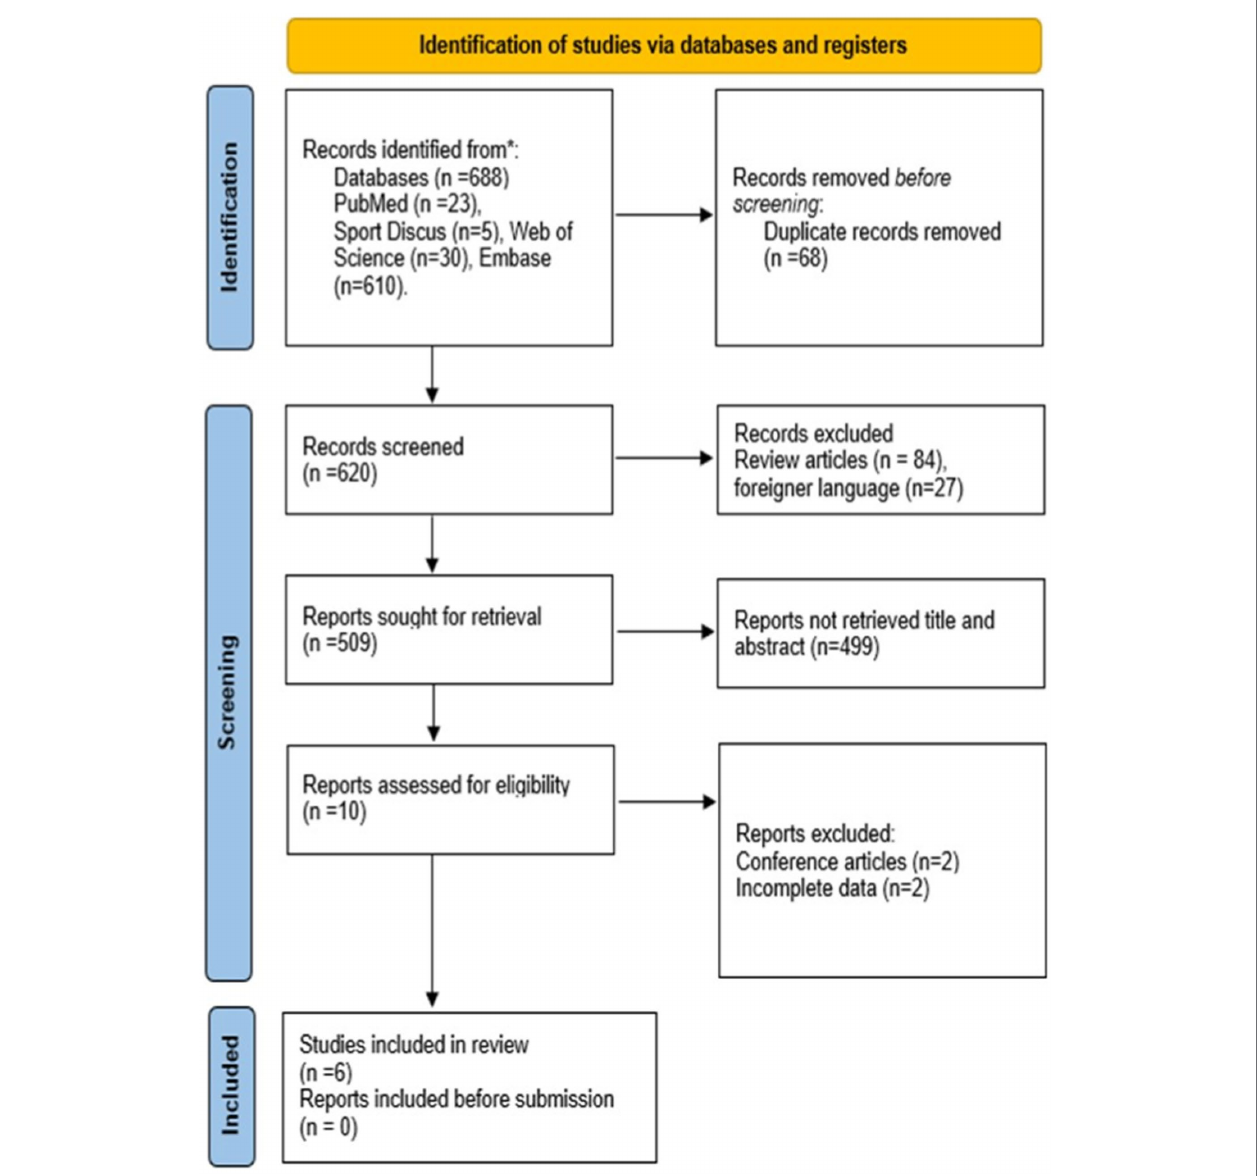
FIGURE 1 | Flowchart diagram of the study selection process (PRISMA